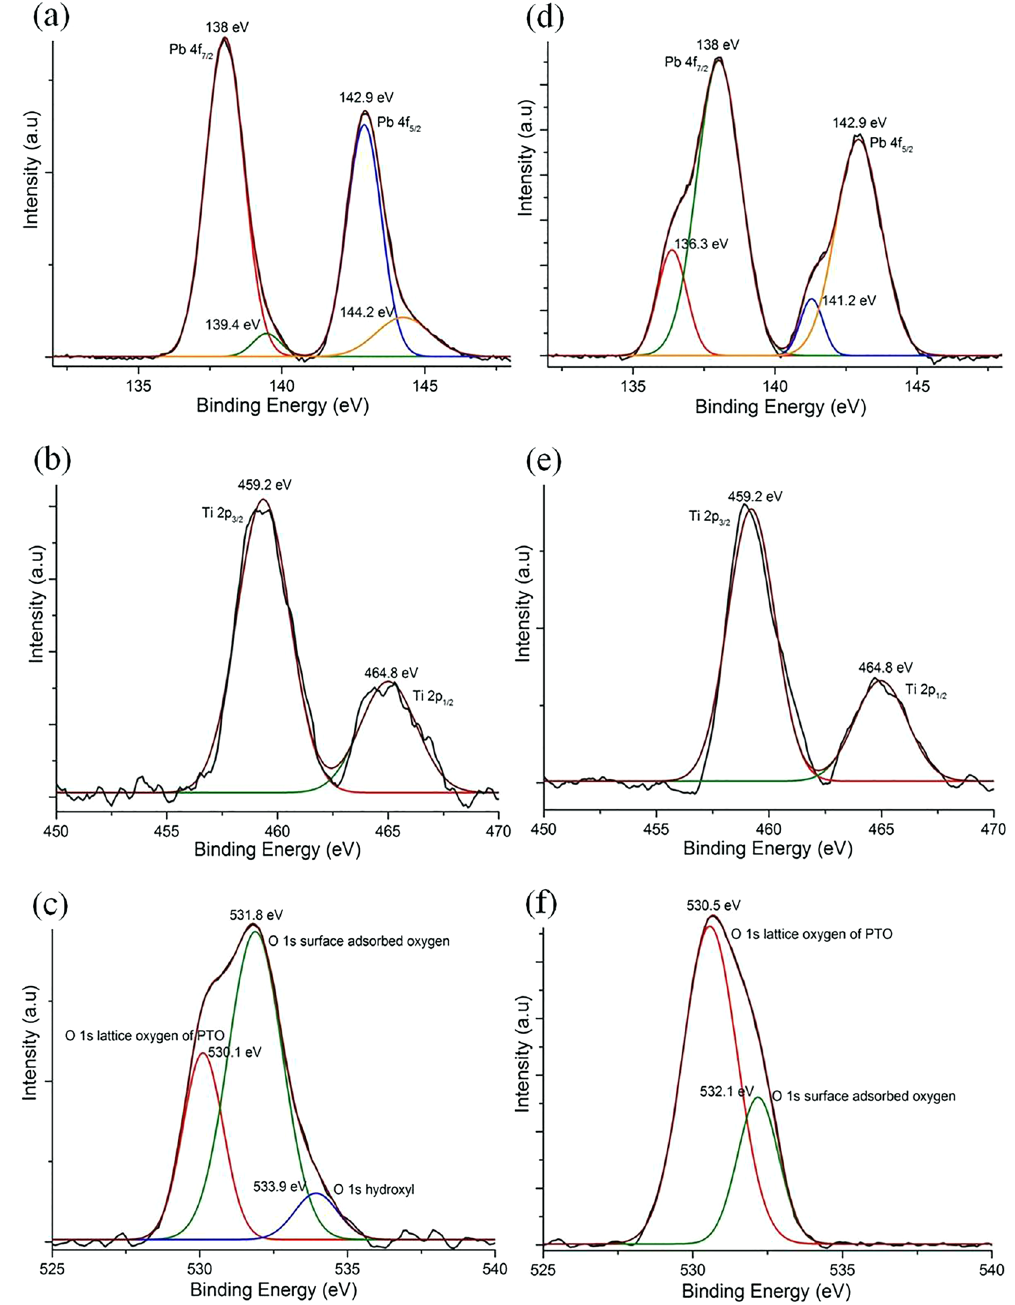
Figure 6. ( a – c) XPS spectra of non-irradiated PTO nanoparticle. ( d – f ) XPS Spectra of irradiated PTO nanoparticle. From top to bottom core level spectra of Pb 4f, Ti 2p and O 1s plotted with deconvoluted